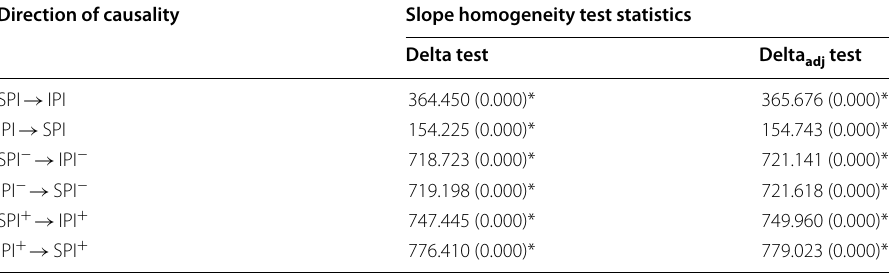
Table 6 Results of homogeneity